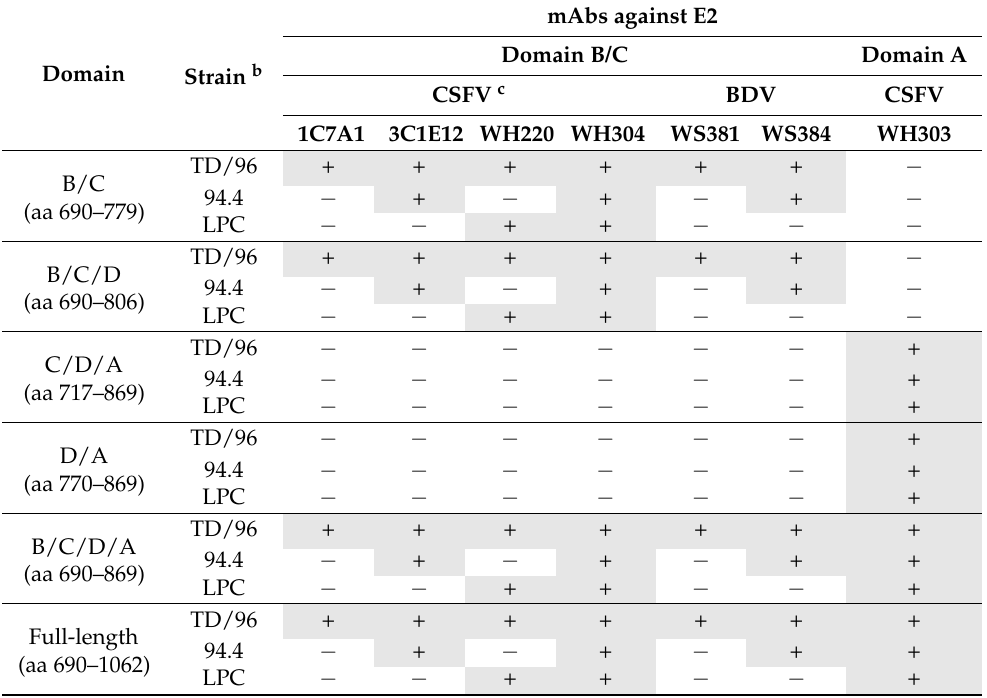
mAbs against E2 Domain